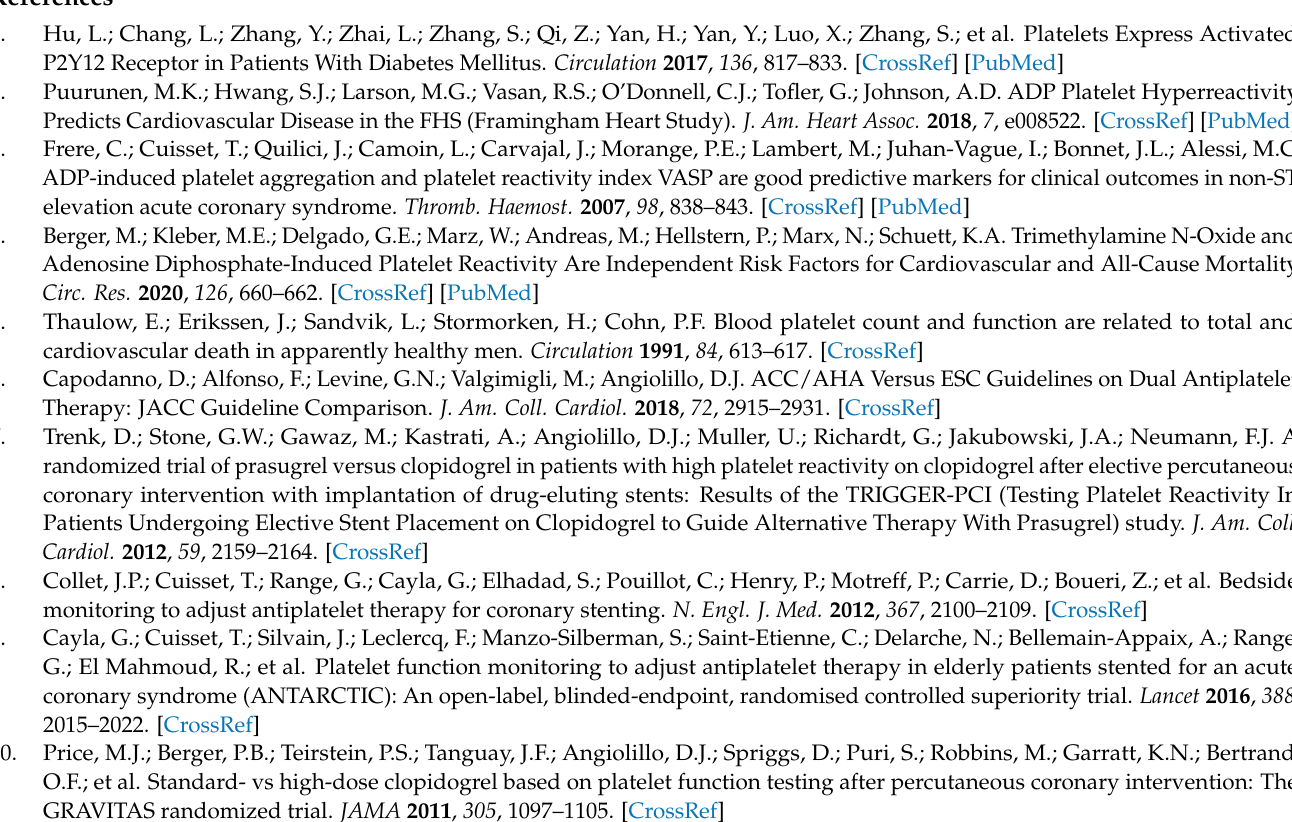
Figure S8: Prediction function of cox models for 464 patients in the Low platelet reactivity group, 545 in the Reference group and 511 in the High platelet reactivity group to assess the continuous relationship between HbA1c, hsCRP and eGFR on cardiovascular (A) and all-cause mortality (B). All continues variables were modeled with restricted cubic splines. Reference values were based on ESC guidelines for cardiovascular disease prevention and observational studies (eGFR: 60 mL/min, HbA1c: 7% and hsCRP 3 mg/L). The dark lines indicate the hazard function while the shaded area denotes the 95% confidence interval. Each model was adjusted for age and sex (model 1). Figure S9: Platelet reactivity and cardiovascular mortality in the LURIC study. Association between ADP- induced CD63 expression and cardiovascular and all-cause mortality in patients with Aspirin